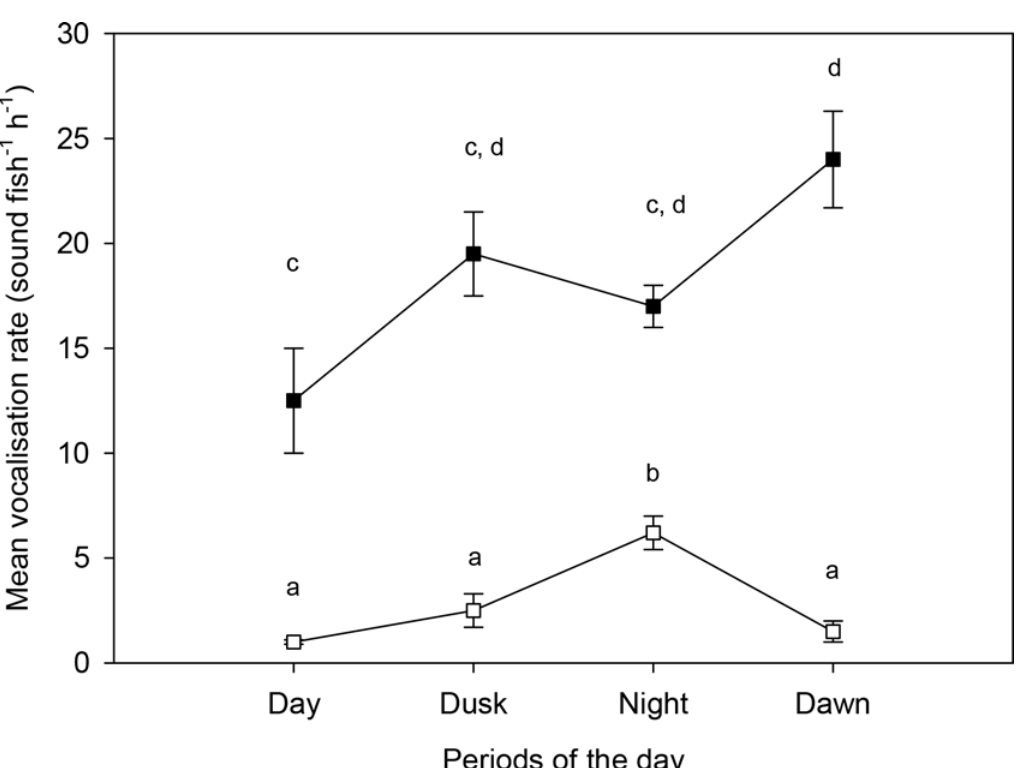
Fig 5. Comparison of vocalisation rate (mean ± SEM; n = 5) during different periods of the day. Dark square represent grunt sound and white square represent growl sounds. Different letters indicate statistically significant differences between individual means within either growls or grunts (Tukey test; p <